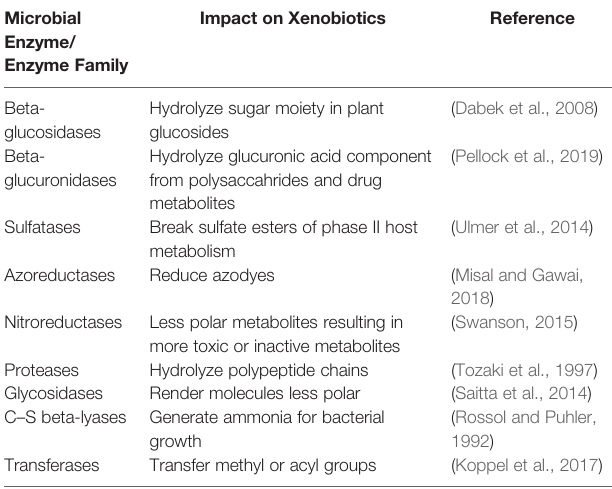
TABLE 1 | Some gut bacterial enzyme families encoded in the microbiome and their impact on xenobiotics. Microbial